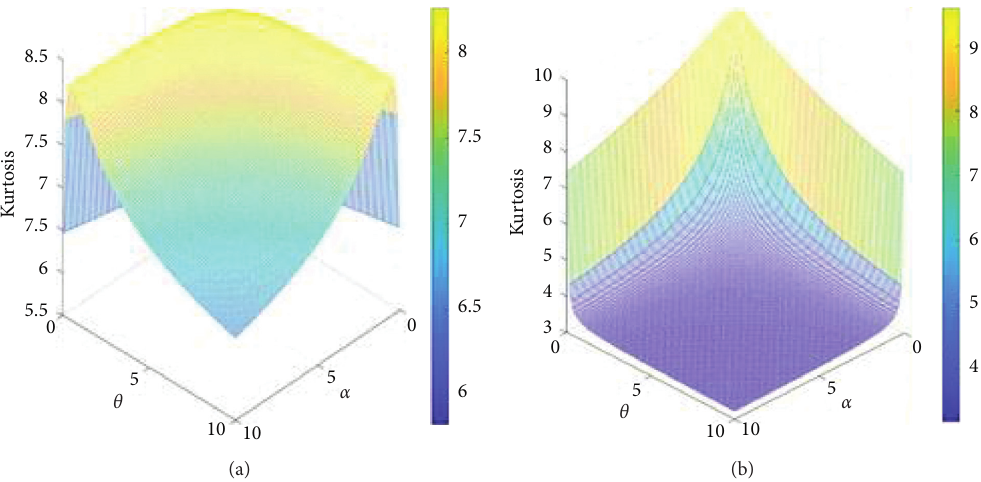
Figure 4: Plots of the kurtosis of the TIITLIFW distribution. (a) Kurtosis for λ � 1 . 1. (b) Kurtosis for λ �